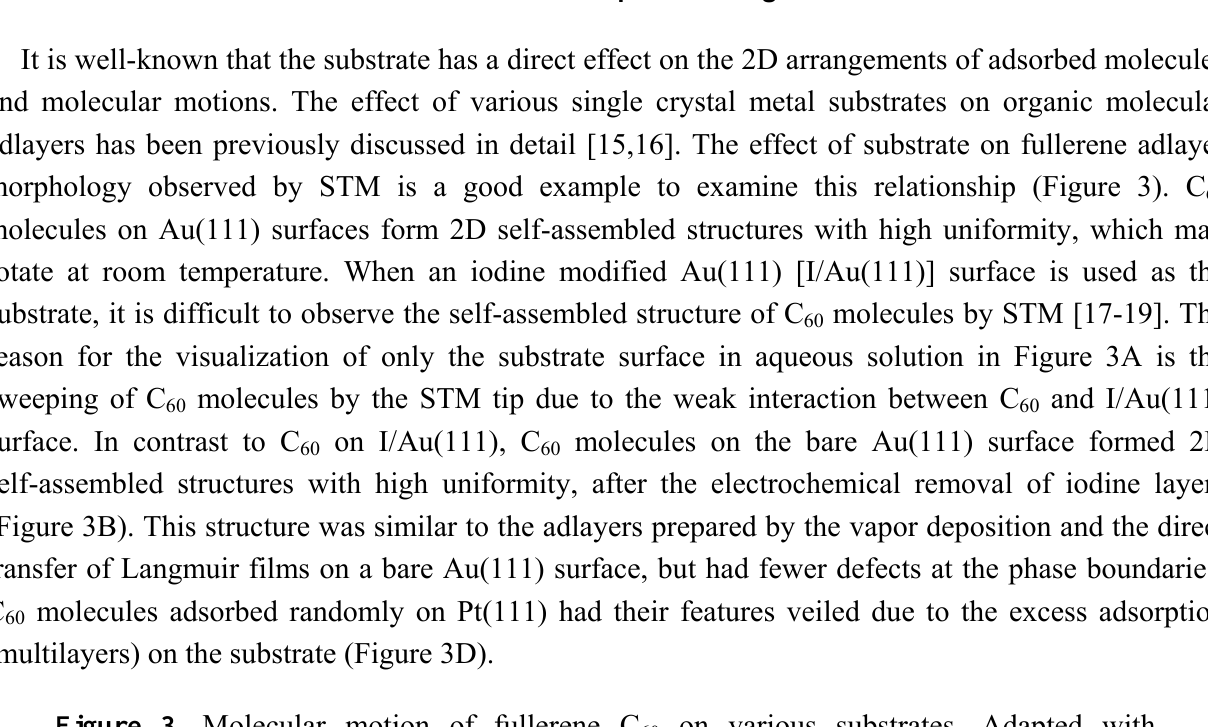
Figure 3. Molecular motion of fullerene C permission from reference [18]. Copyright 2004 American Chemical